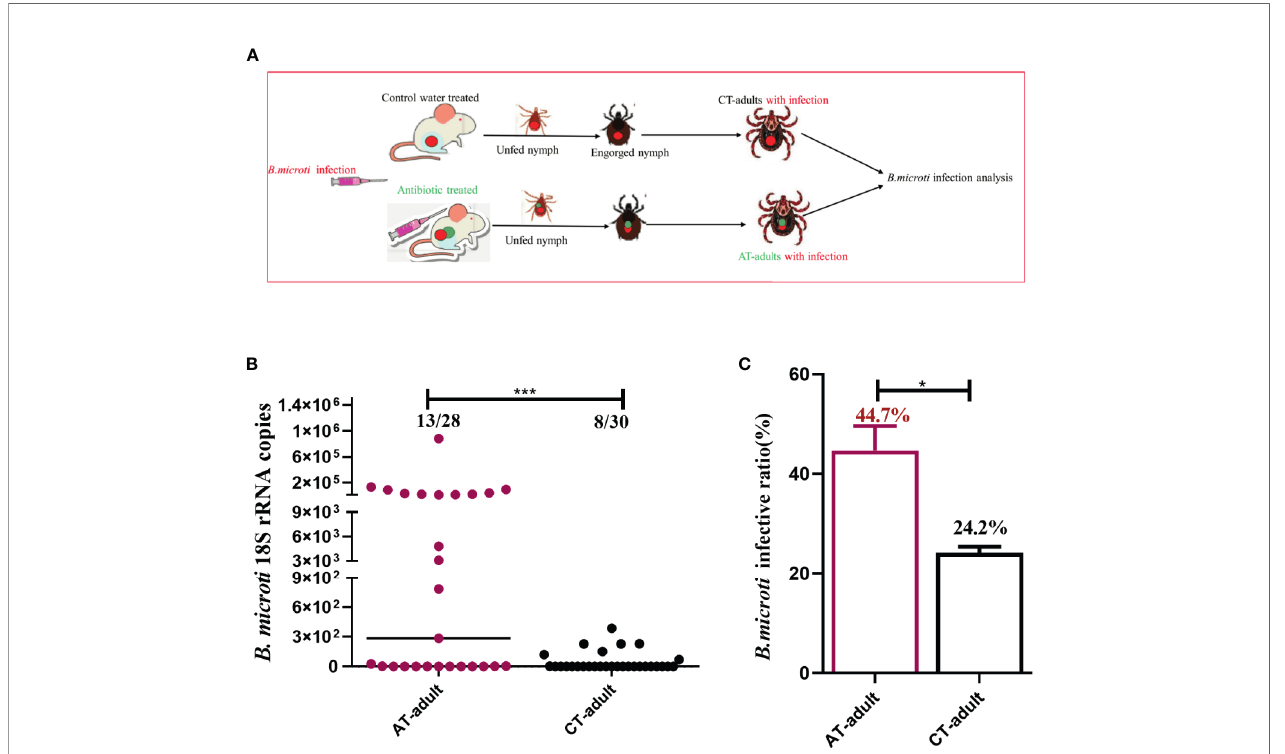
FIGURE 3 | Tick microbiota dysbiosis impairs capacity to transstadially transmit B. microti from nymphs to adult ticks. (A) The experimental work fl ow for B. microti infection analysis in adult ticks. Nymphs were fed on an antibiotic cocktail-treated or water control mice with B. microti infection to generate AT adults with infection and CT adults with infection, respectively. (B, C) Assessment of the antibiotic-mediated microbiota dysbiosis regulation of tick capacity to transstadially transmit B. microti . * represents p < 0.05, *** means p <